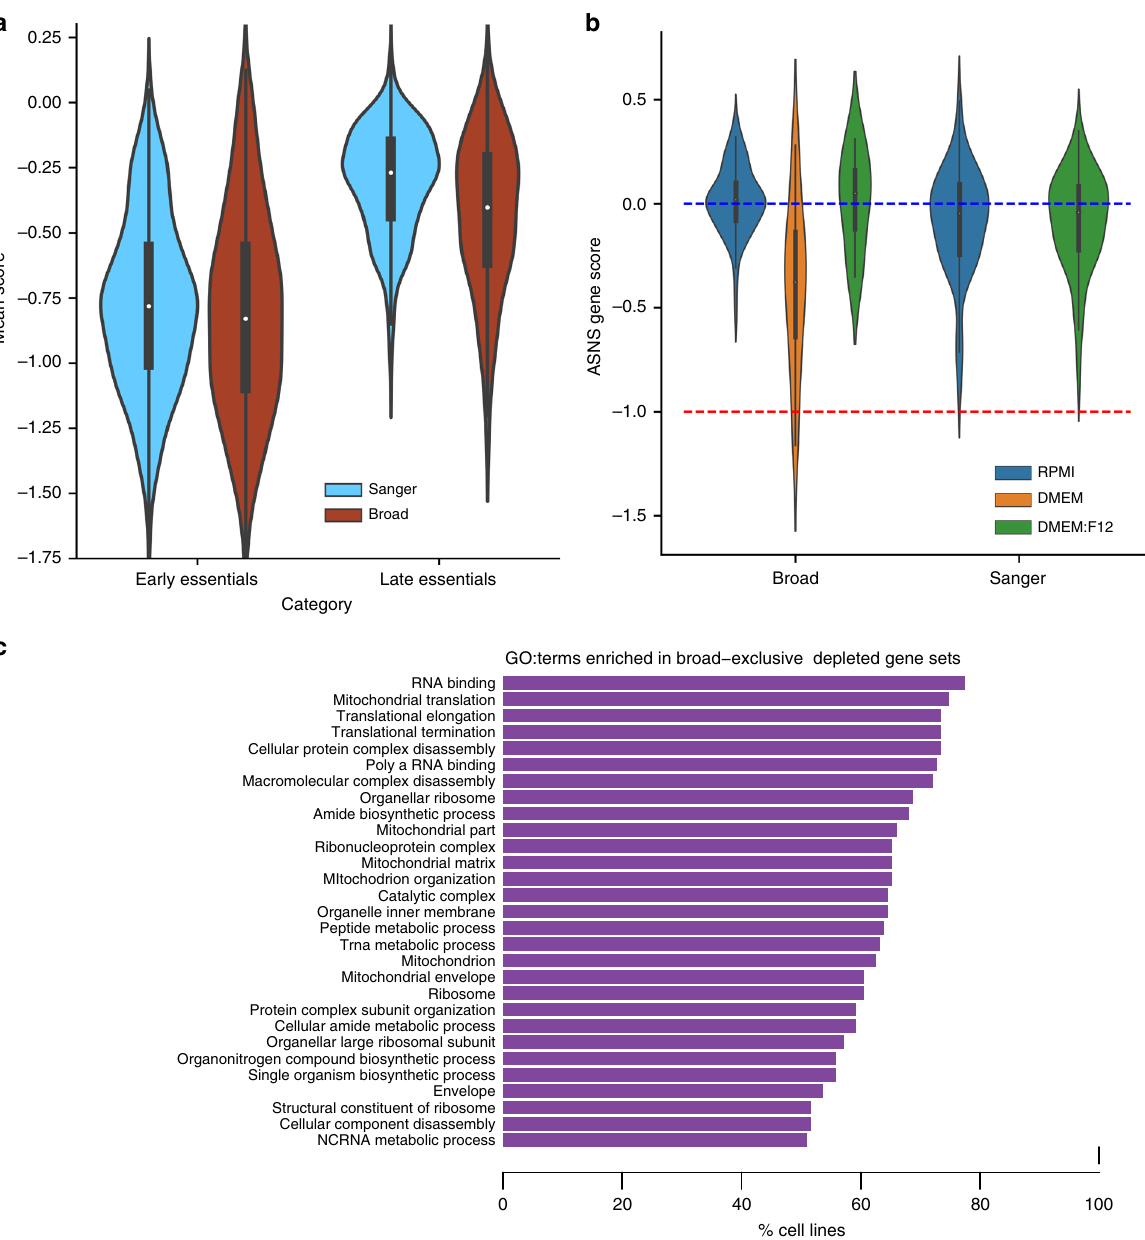
Fig. 5 In fl uence of time point. a Distribution of early and late common dependency gene scores in the Broad and Sanger data sets averaged across cell lines. Boxes cover the interquartile range with the median indicated by a horizontal line. Whiskers extend up to 1.5 time the interquartile range with outliers shown as fl iers. b Distribution of corrected gene scores for asparagine synthetase (ASNS) by media and institute. Blue and orange lines indicate the median of nonessential and essential gene scores, respectively. c GO terms signi fi cantly enriched in Broad-exclusive dependencies. For each GO term the bar length indicates the ratio of cell lines showing Broad-exclusive dependencies with a statistically signi fi cant enrichment of that GO